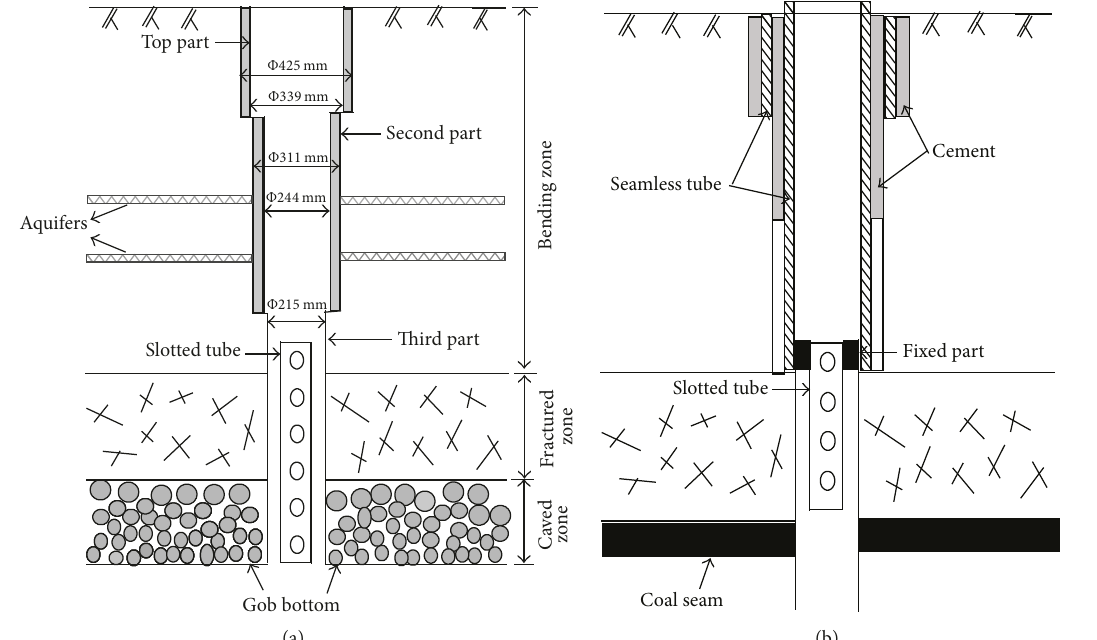
Figure 3: Sketch of two surface well structures: (a) surface well structure used in the Yongan mine area and (b) surface well structure used in the Chengzhuang mine